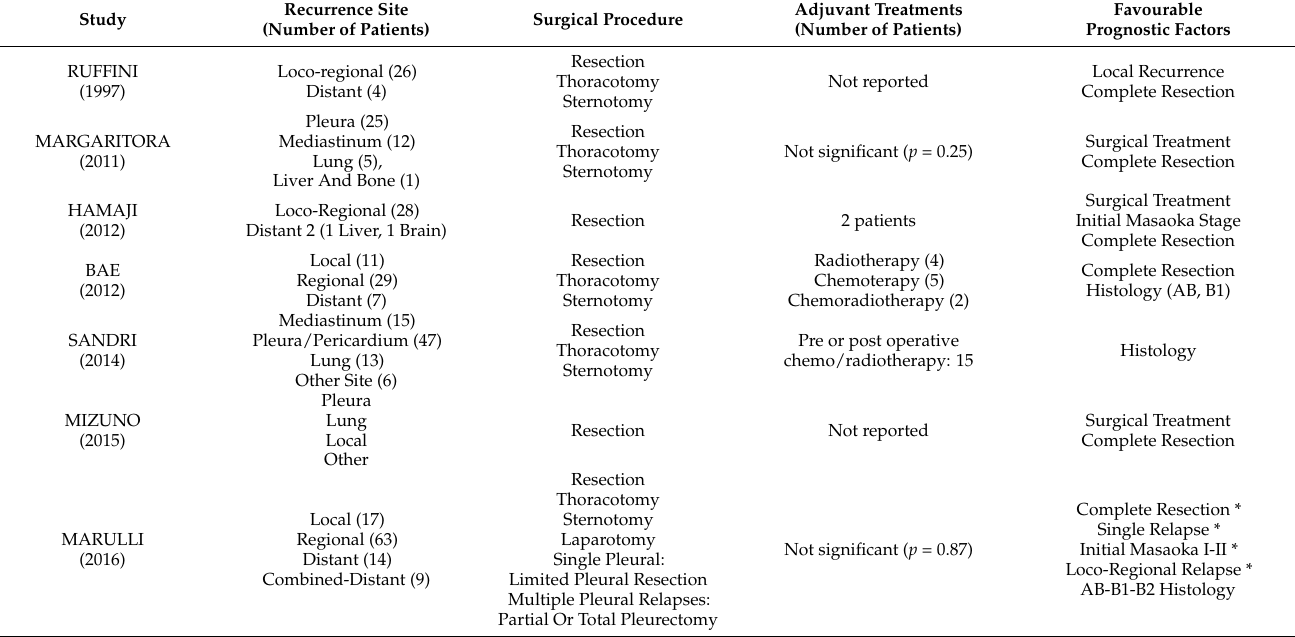
Table 2. Recurrence characteristics, surgical procedure and prognostic factors of the included studies * significant also at multivariable analysis. Patient numbers of Mizuno et al. are not reported due the concomitant presence of patients with thymic